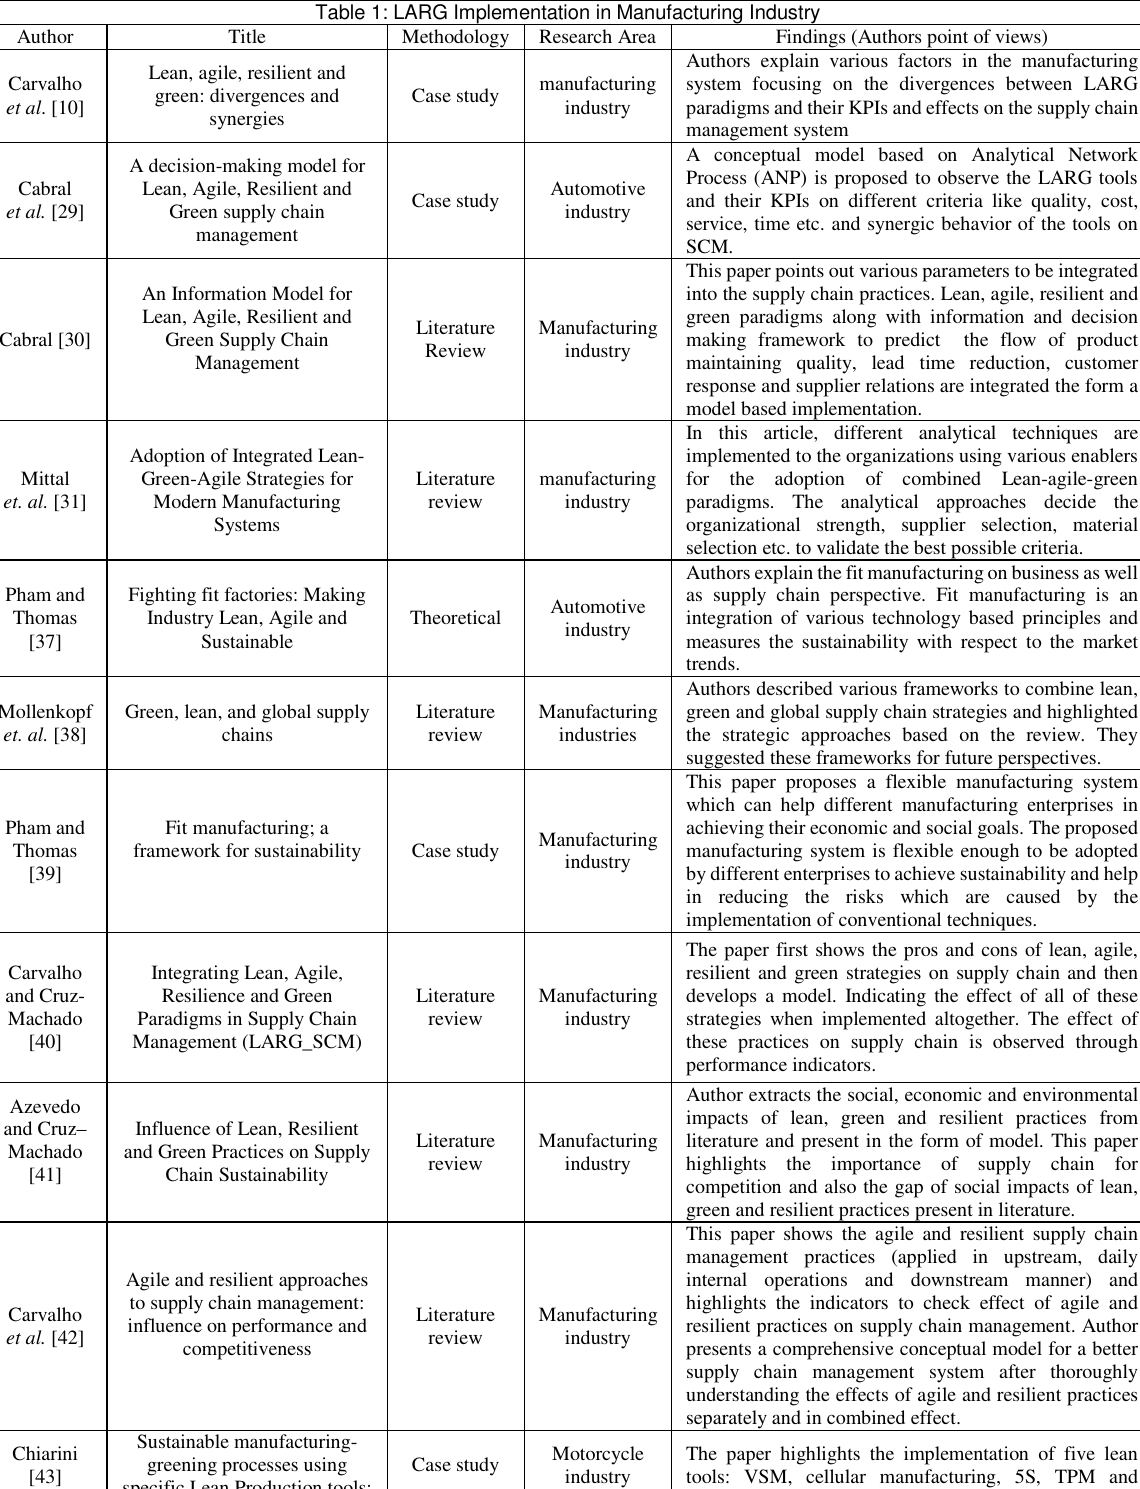
Table 1: LARG Implementation in Manufacturing Industry